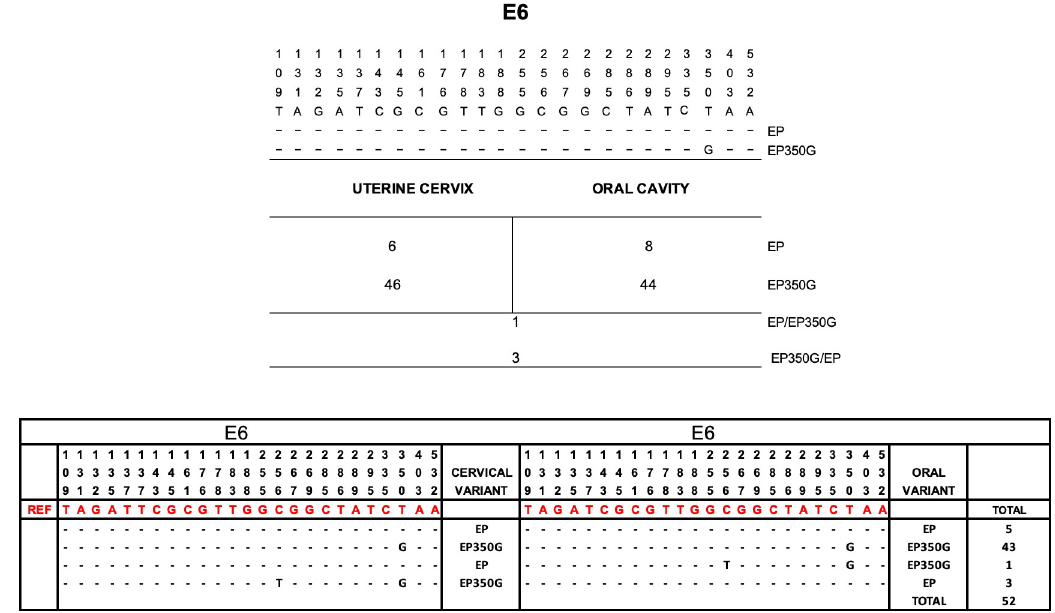
Fig 3. E6 region sequences representative of HPV16 variants. Summary of the variants identified in the oral cavity and uterine cervix. The predominant variant in both anatomical regions was the European variant, an intravariant EP